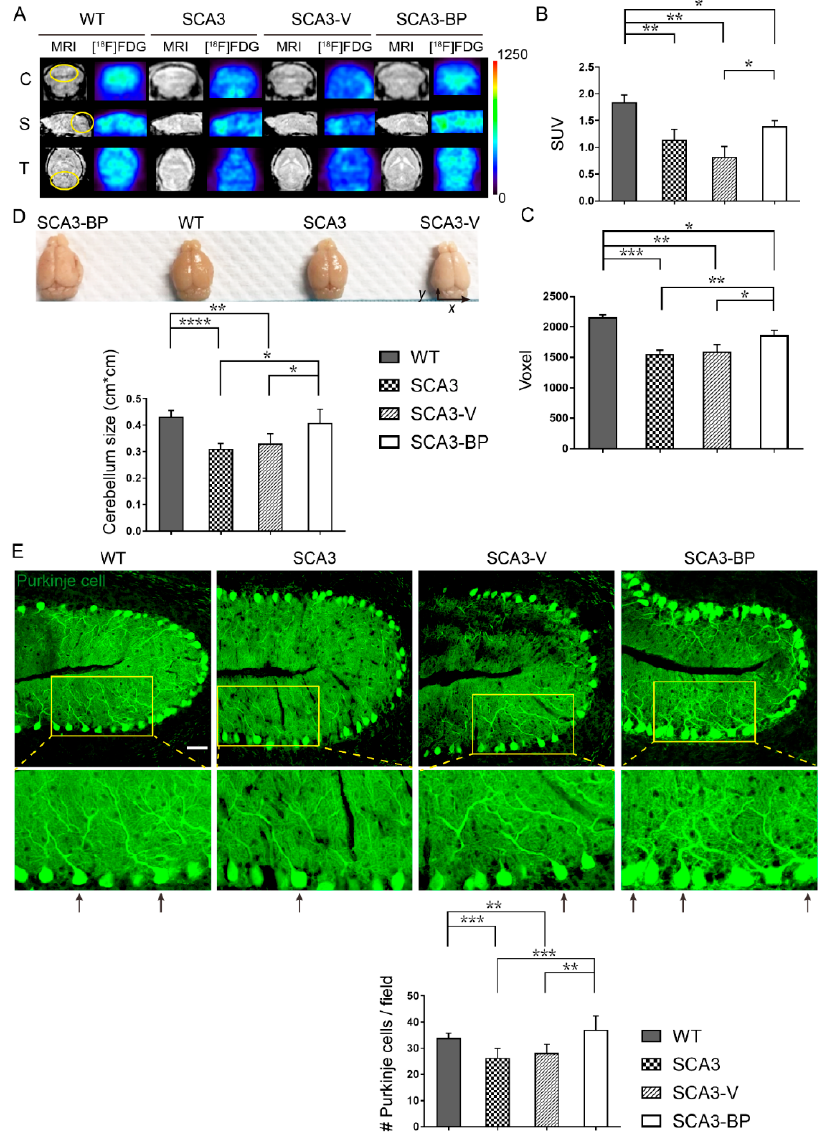
Figure 2. n -BP protected the Purkinje cells from loss to increase the metabolic activity in the cerebel- lum in the SCA3 mice. ( A ) The representative PET ([ 18 F]FDG) and MR images, in coronal ( C ), sagittal (S), and transverse (T) views, of SCA3 mice showing that n -BP treatment for 12 weeks could alleviate the impairment of glucose analogue metabolism and restore the cerebellar function (yellow ROI). Each group contained three 35-week-old mice for the analysis. ( B ) The panel presents the values corresponding to the standard uptake value (SUV) based on the in vivo imaging of glucose metabolic activity (yellow ROI of Figure 2A). ( C ) Histogram indicated the MR evaluated cerebellar size in voxel, reflecting the cerebellar atrophy in SCA3 or SCA3-V animals. ( D ) The images exhibit the whole brain of WT and SCA3 mice with indicated treatments for five weeks. Statistical results sug- gested that the n -BP treatment could mitigate the atrophy of cerebellum, and no difference in cere- bellum size (x × y = cm × cm) was found between WT and SCA3-BP groups (at 28 weeks of age). Three animals were used for the statistical data. ( E ) Cerebellar tissue sections of the mice were stained with calbindin (green, Alexa Fluor 488 probed) to label the Purkinje cells in cerebellar lobes III–V. The representative images and zoomed parts of Purkinje cells are shown. Purkinje cells with- out fragmented neurites are indicated by arrows. The counted number of all Purkinje cells in each captured field are calculated in the bottom panel. Bar = 50 μ m. Data represent mean ± s.d. of three independent experiments (total cell counts in 28 fields). * p < 0.05, ** p < 0.01, *** p < 0.001, **** p < 0.0001 (Student’s t -test).